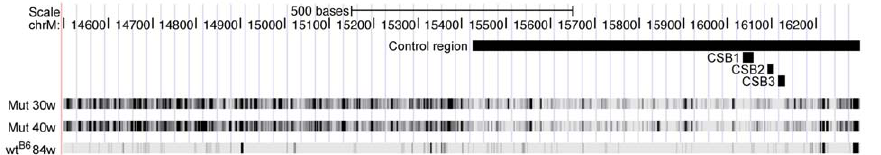
Figure 4. Mutation frequencies for the two mtDNA mutator mice (Mut 30w and Mut 40w) and the C57Bl/6N 84-week-old mouse (wt B6 ) in a region including the control region. The locations of the control region and the conserved sequence blocks (CSB) 1–3 are indicated by horizontal black lines.